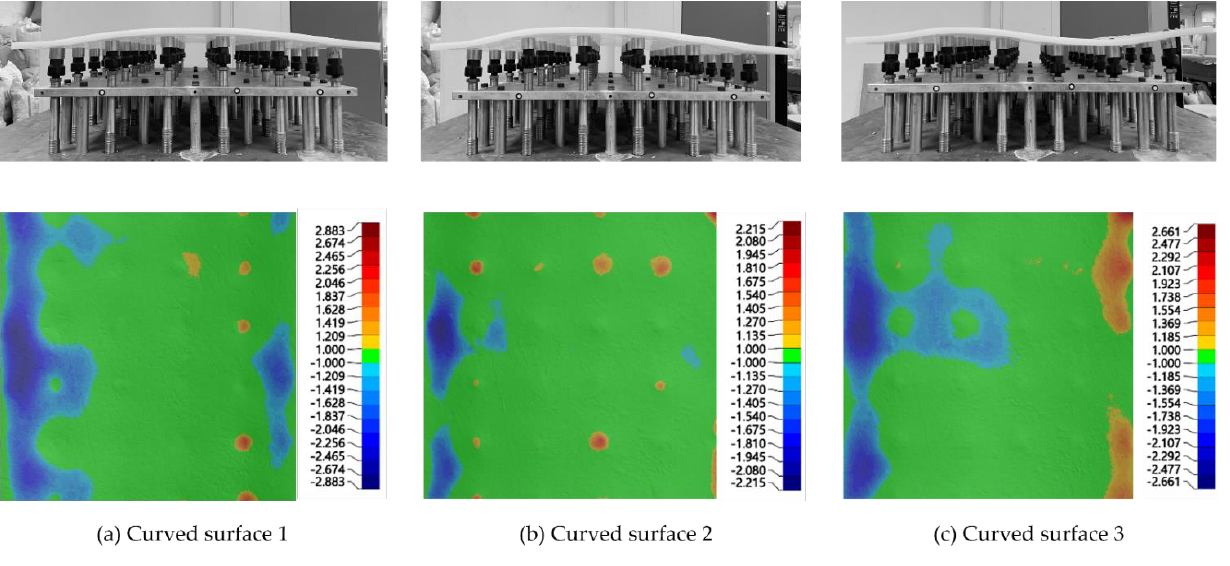
Figure 8. Shape error of fixed type.